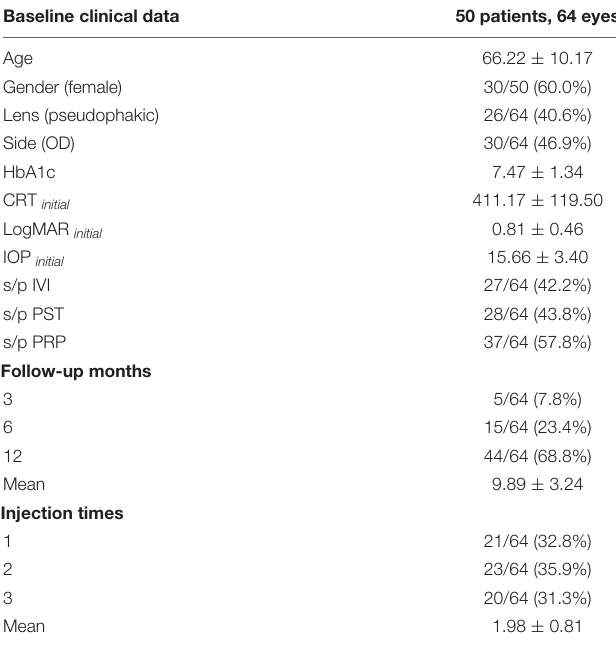
TABLE 1 | Baseline clinical data and status of OCT